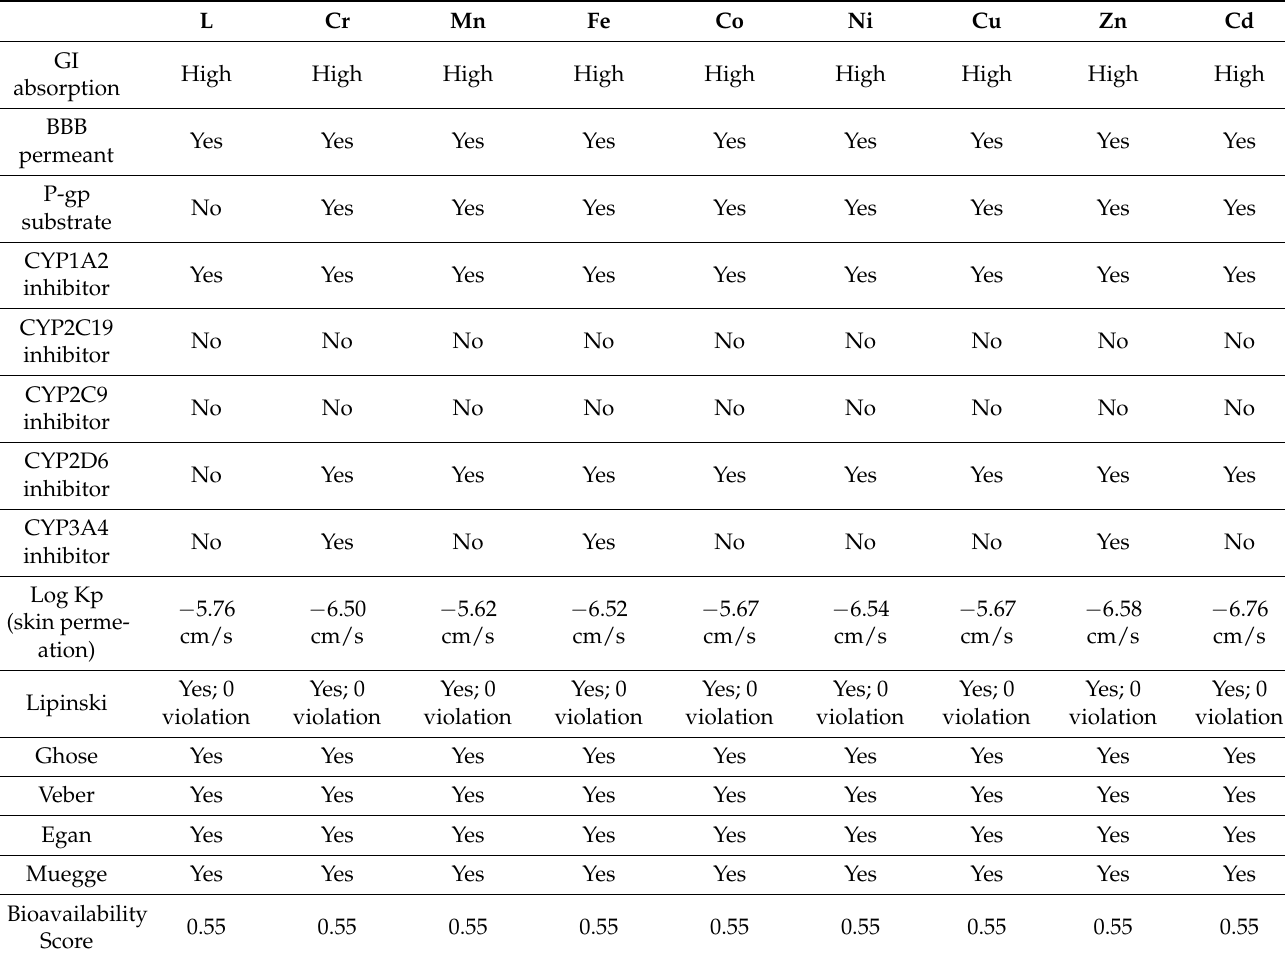
Table 5. Pharmacokinetics and drug likeness of synthesized